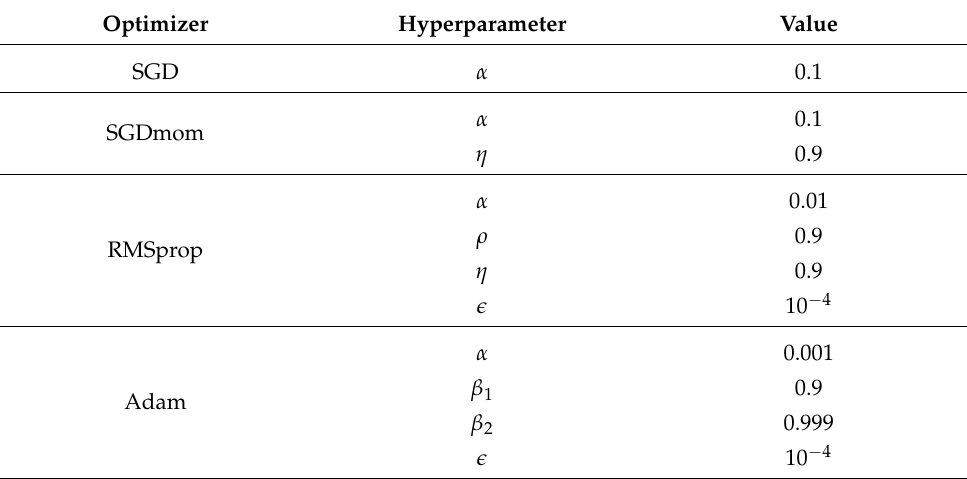
Table 7. Range of each optimizer